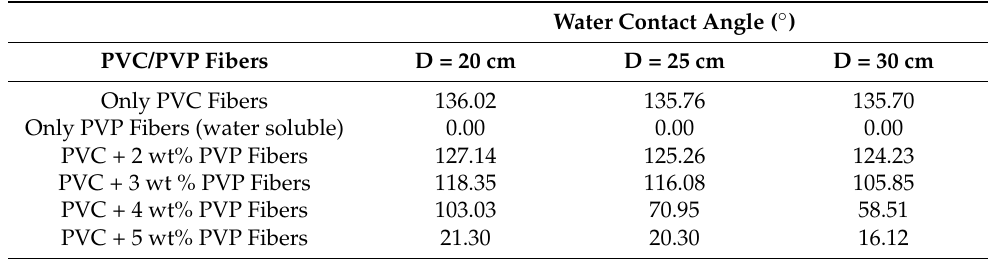
Table 7. The contact angle values for electrospun PVC with PVP [31].